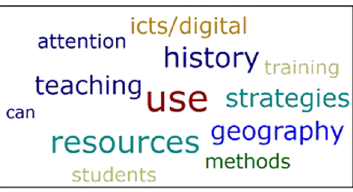
Fig. 2 Word cloud for the subcategory educational training. Source: fi